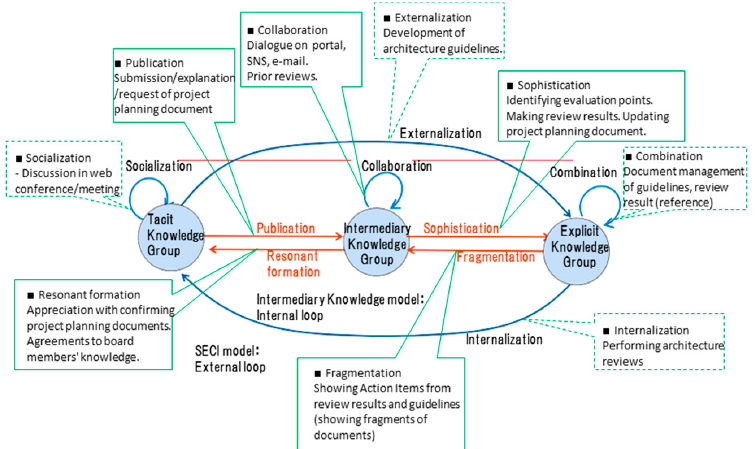
Figure 8. Global digital transformation communication (GDTC) model with knowledge sharing